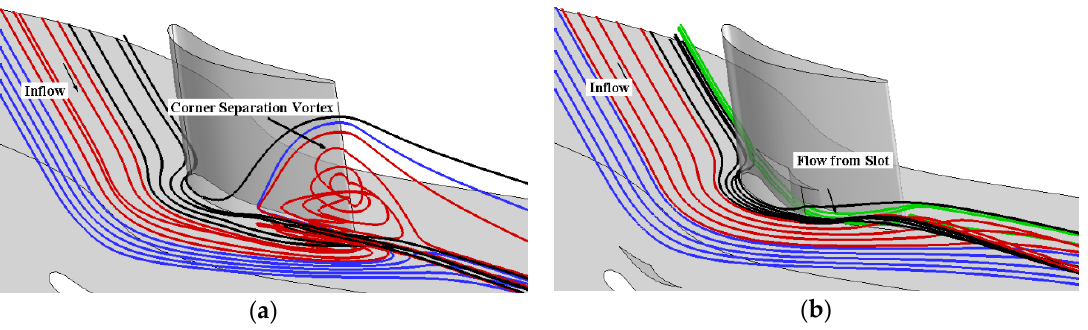
Figure 4. Volume streamlines in the flow passage: ( a ) original cascade; and ( b ) slotted cascade.